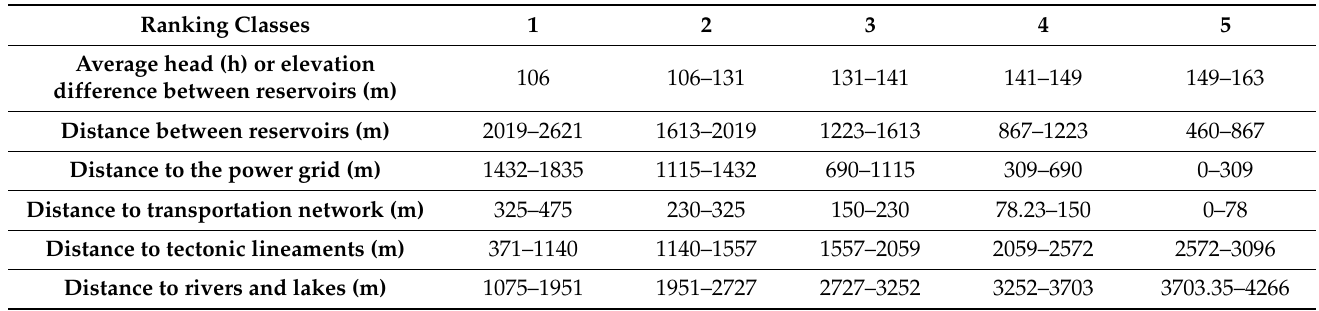
Table 3. Criteria classification ranking